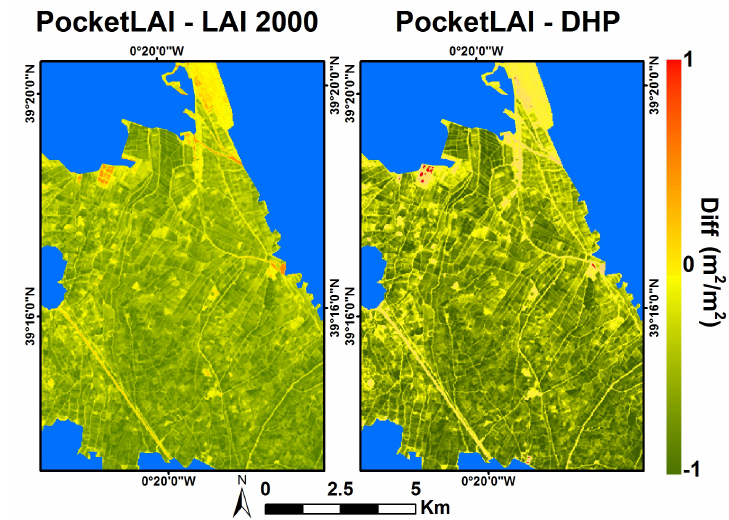
Figure 6. Difference maps between PAI ef f derived from PocketLAI and LAI-2000 ( left ); and DHP ( right ).